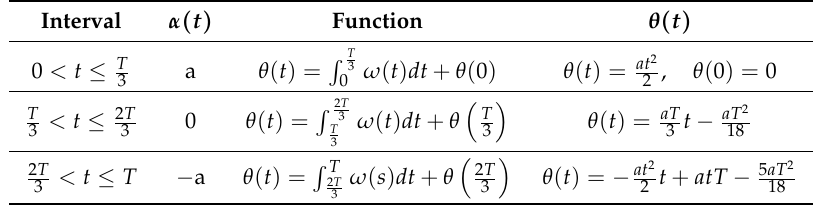
Table 4. Position for each acceleration